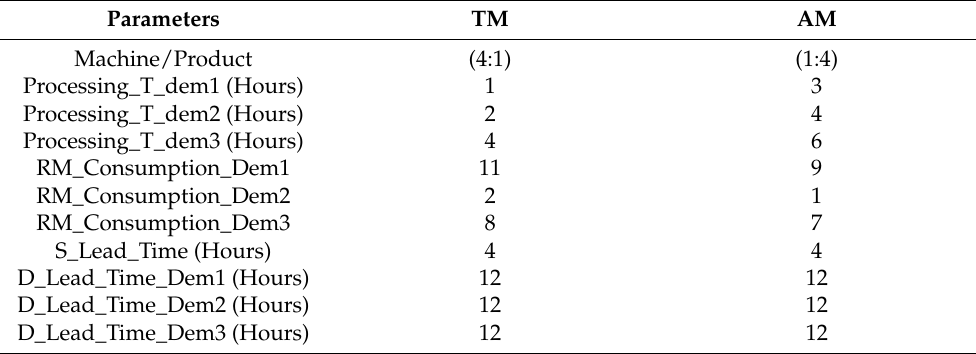
Table 6. Model parameters.